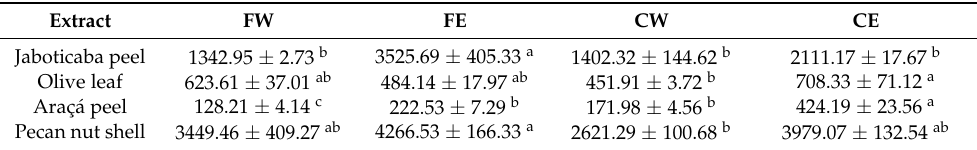
Table 2. Ferric reduction capacity ( µ M Fe +2 g − 1 , d.w.) of the natural